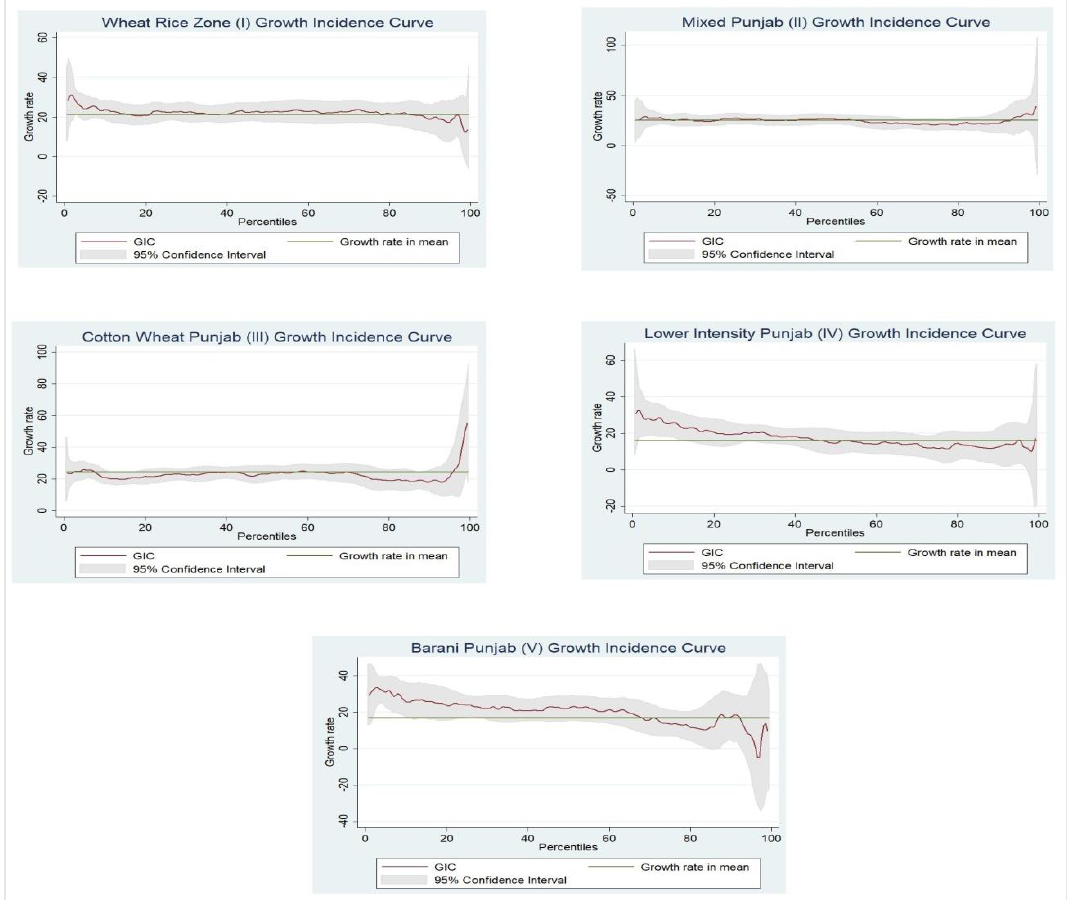
Figure 2. Growth incidence curve for farming communities across all agro_climatic zones in Punjab. The comparative measures across all zones for non-farming communities show that households in zones III (IV) were most affected, while households in zone V (II) were least affected in terms of poverty (inequality) in 2001–2002 [36,53]. Similarly, outcomes for 2015–2016 exhibit that households in zones IV (V) were the most affected and households in zones V (III) were the least affected in terms of poverty (inequality)